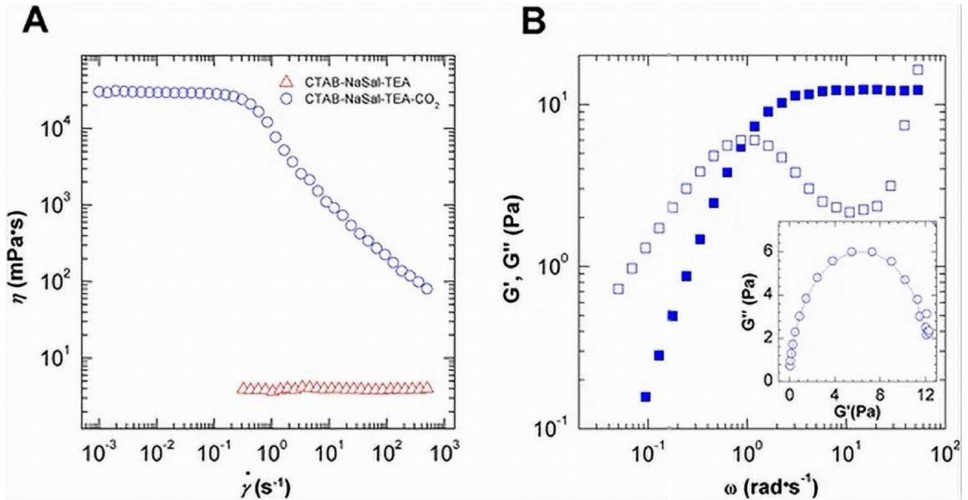
Figure 16. ( A ) Static rheology and ( B ) dynamic rheology of 50 mM CTAB-NaSal-TEA before and after bubbling CO 2 at 25 ◦ C (with a molar ratio of 1:1:5)